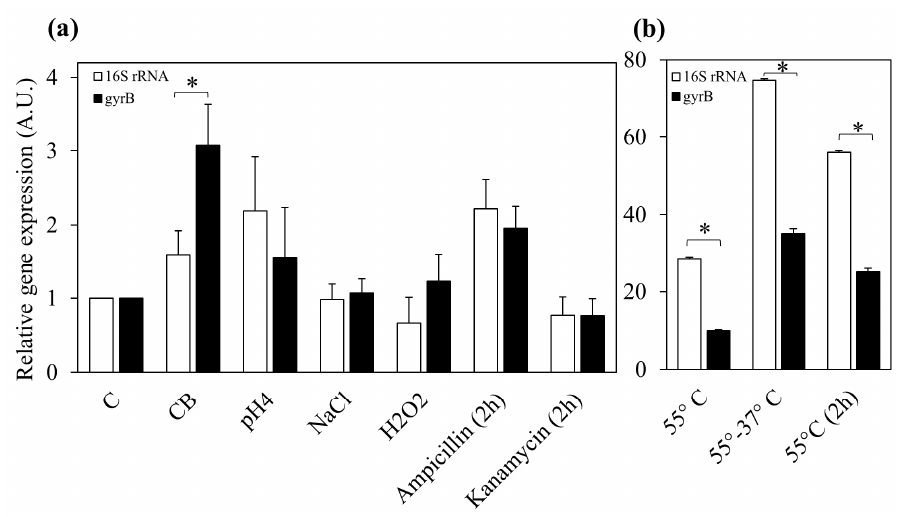
Figure 4. Relative expression of DinJ-YafQ transcript in L. paracasei 4366 measured using 16S rRNA (white) or gyr B (black) as control genes. ( a ) Relative expression in response to nutritional, acidic, osmotic, oxidative stress conditions and in response to exposure to antibiotics, ( b ) Relative expression in response to thermal stress. DinJ-YafQ relative expression is reported as fold changes vs. control (C) condition. Error bars represent the SEM ( n = 2). * significant difference, p < 0.05.